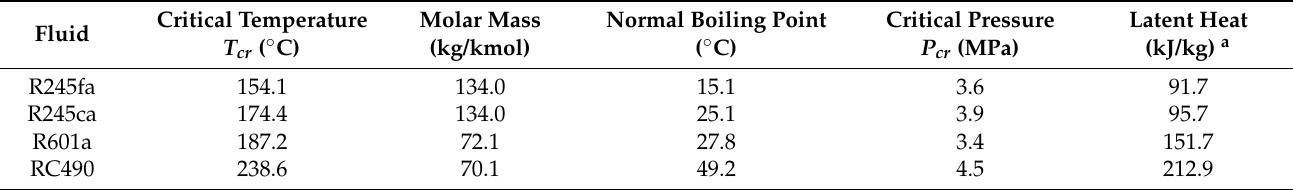
Table 2. The thermophysical properties of the four working fluids.